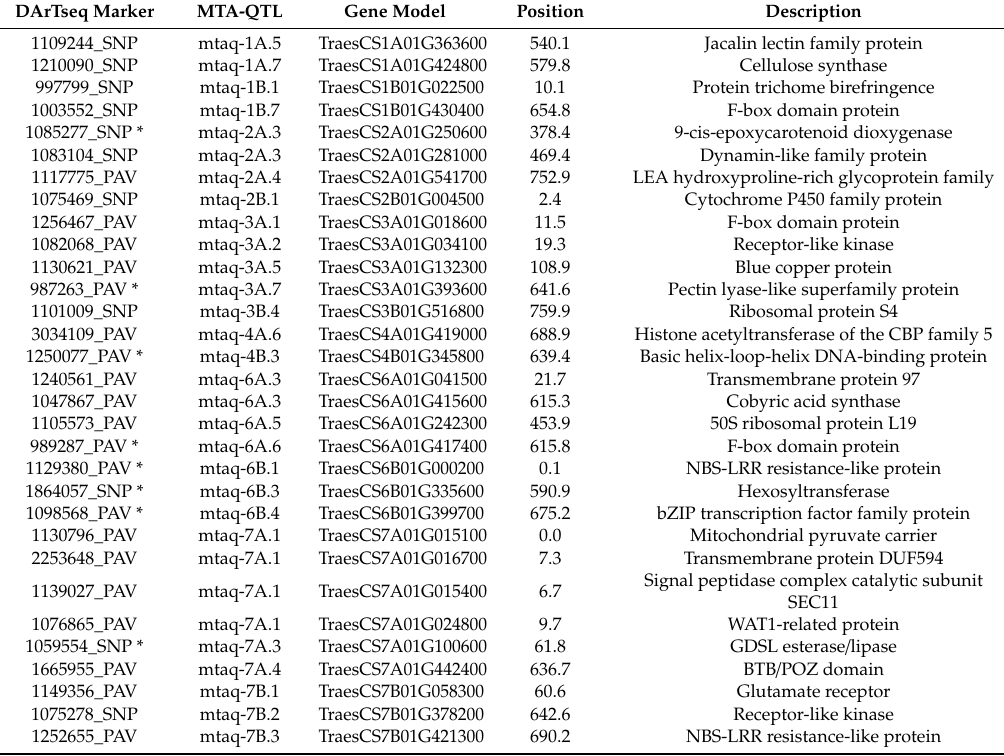
Table 5. Gene models within MTA-QTL positions. Only MTAs with markers mapped against the genome sequence are included. Genome position of the gene model is indicated in